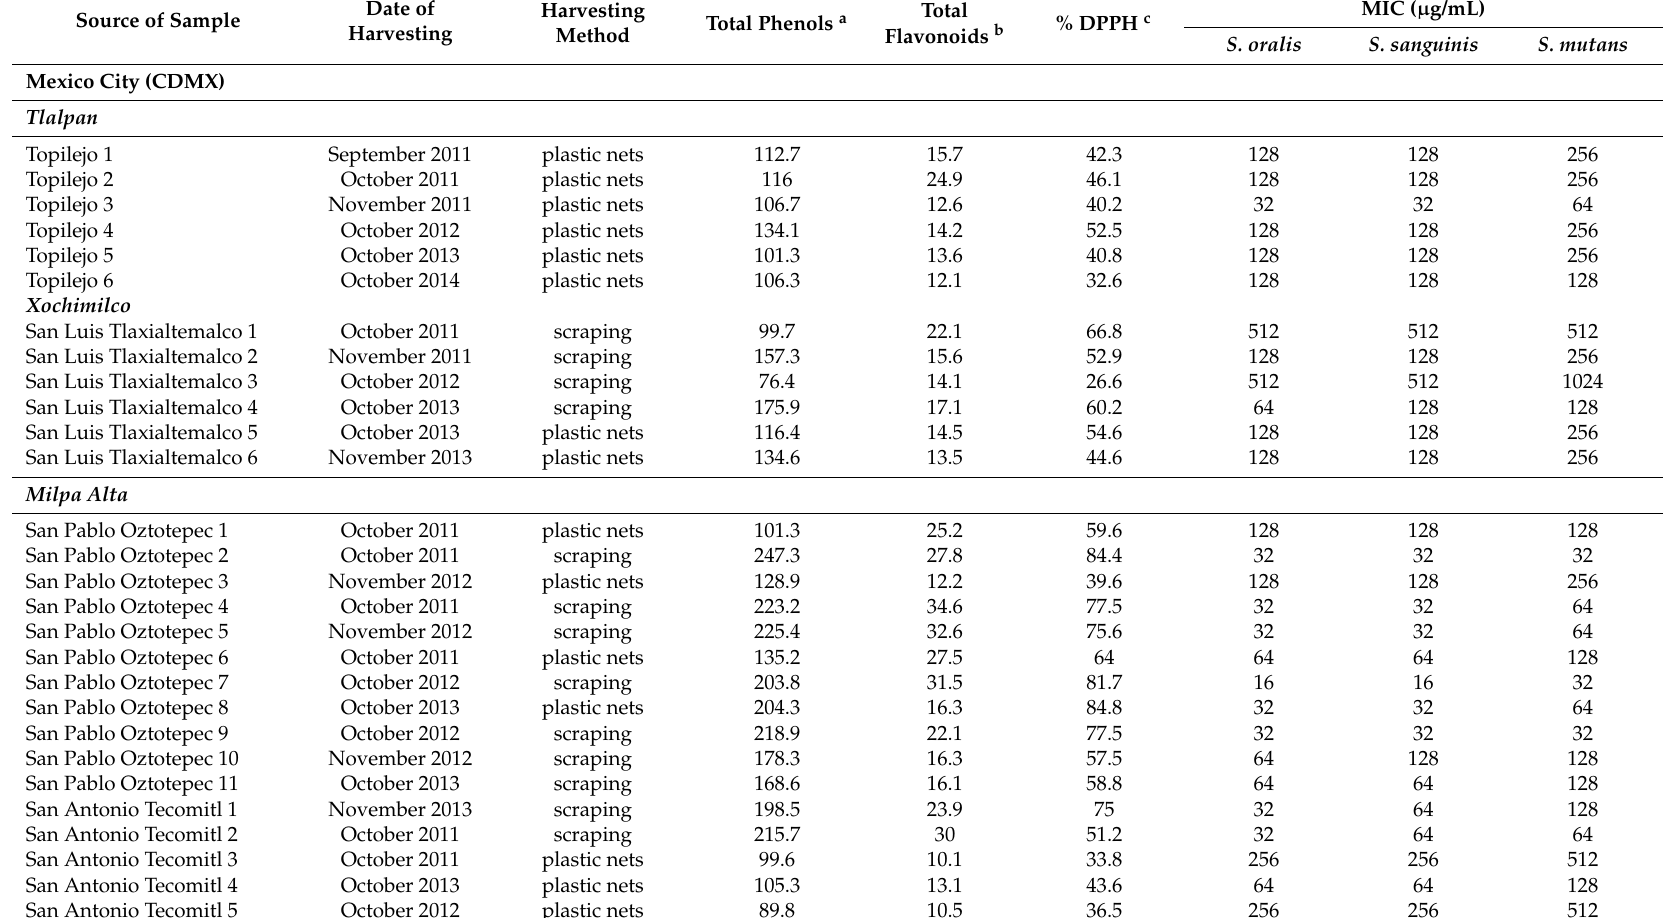
Table 1. Characteristics of the of EEP samples from Mexico City (CDMX), Puebla (PUE), Oaxaca (OAX), Guanajuato (GUAN), Tlaxcala (TLAX), Ecuador (ECUA) and China (CHINA) used in this